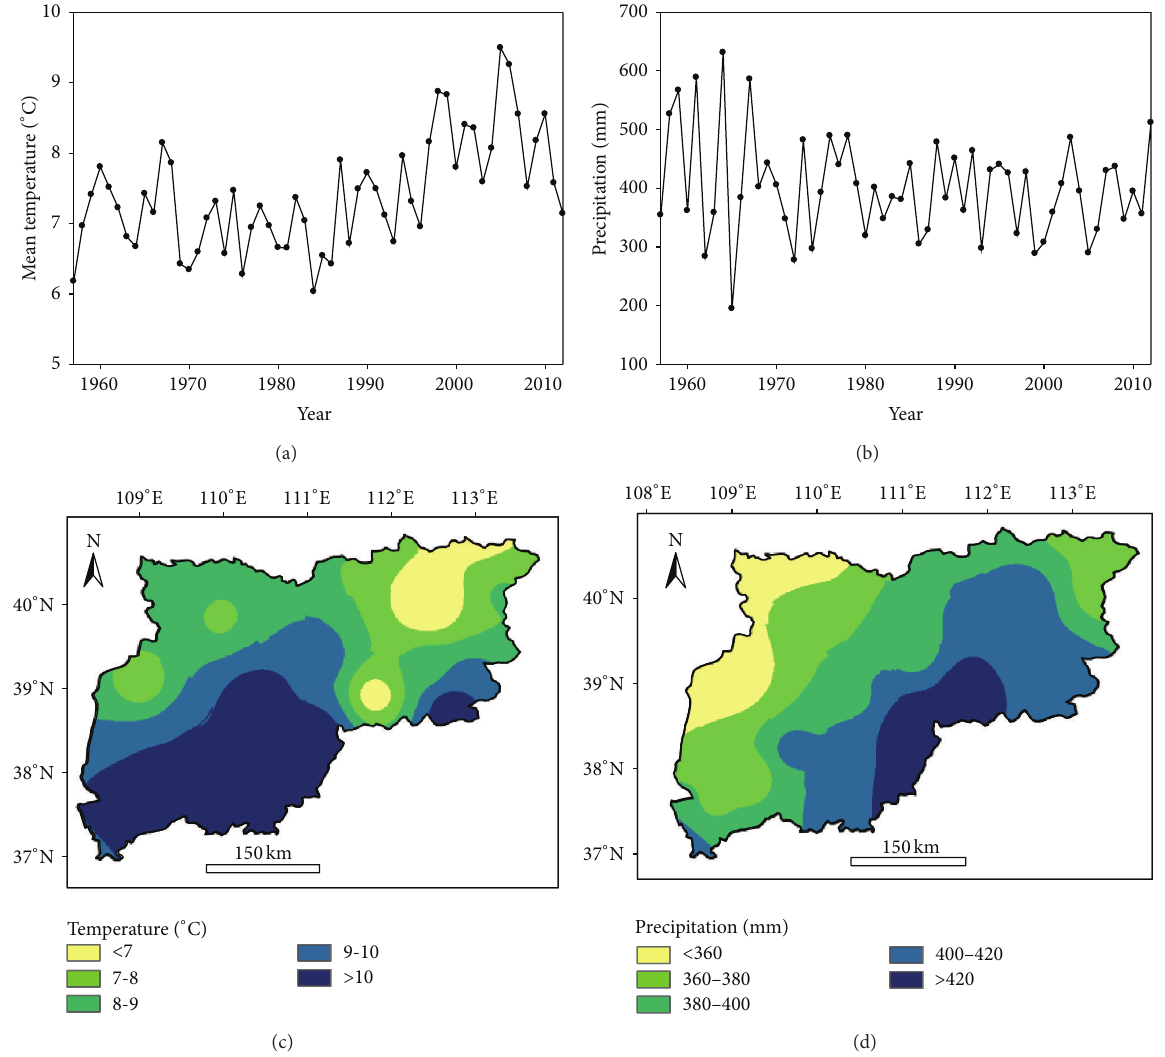
Figure 4: The temporal variation of interannual (a) temperature and (b) precipitation from 1957 to 2012; spatial change in the (c) annual mean temperature and (d) annual precipitation on the northern Loess Plateau from 1998 to